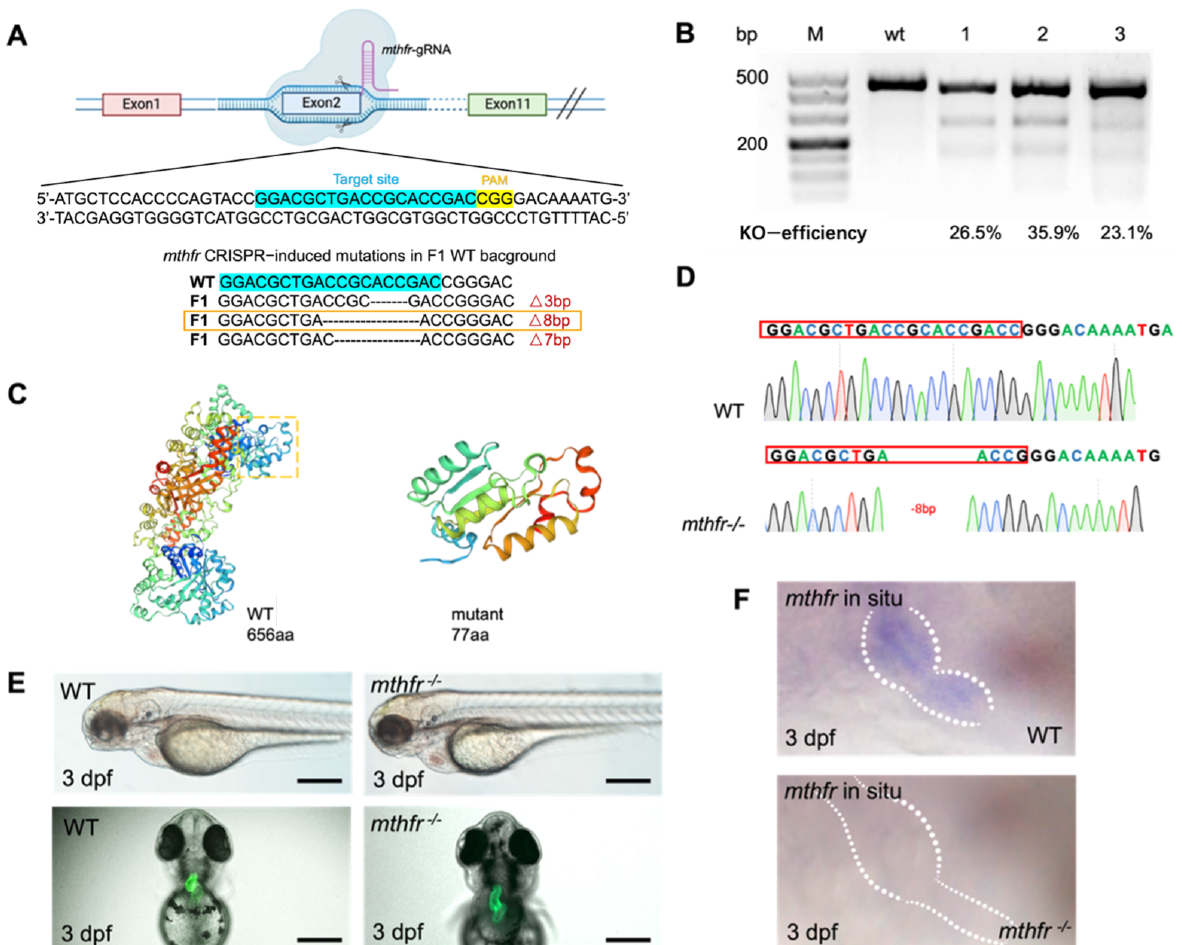
Figure 4. Generation of mthfr mutant using the CRISPR/Cas9 system. ( A ) Design of sgRNA target on exon 2 of zebrafish mthfr gene. The mutation type of code shift selected by orange frame is selected finally. ( B ) Two short DNA fragments were obtained by T7E1 digestion. In the control group, 437 bp fragment was amplified from wild-type embryos with the same set of primers. ( C ) The predicted truncation of Mthfr protein. ( D ) Sequencing map of homozygous zebrafish adults. ( E ) Bright-field views of mthfr − / − zebrafish showed Pericardial enlargement, ventricular enlargement and abnormal heart looping. Scale bars: 500 µ m. ( F ) The results of in situ hybridization showed that the expression of mthfr gene in homozygous mutant zebrafish was